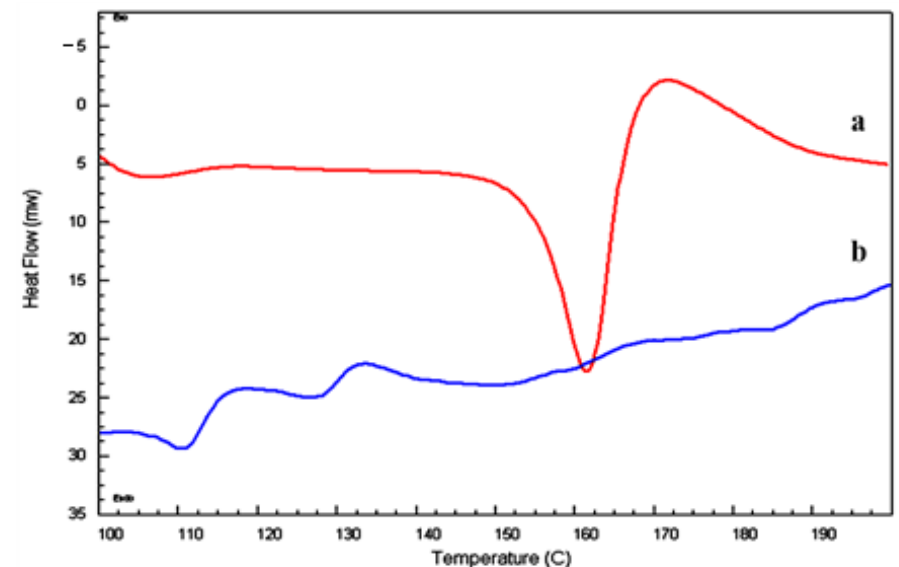
Figure 4. DSC thermogram peaks of pure ibrutinib ITB (a) and IBNS4 (b).